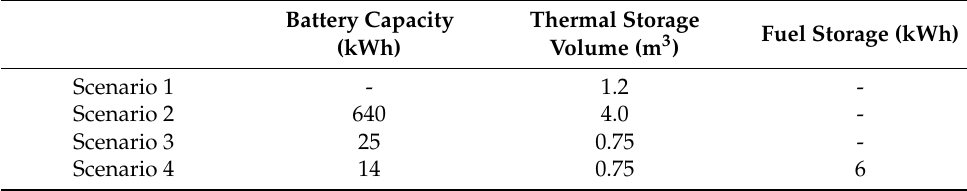
Table 10. The needed storage capacities for the battery, the thermal storage and the fuel storage for each